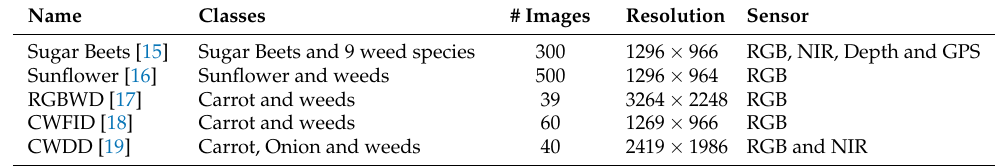
Table 1. Comparison of five different terrestrial agriculture segmentation datasets present in the literature.